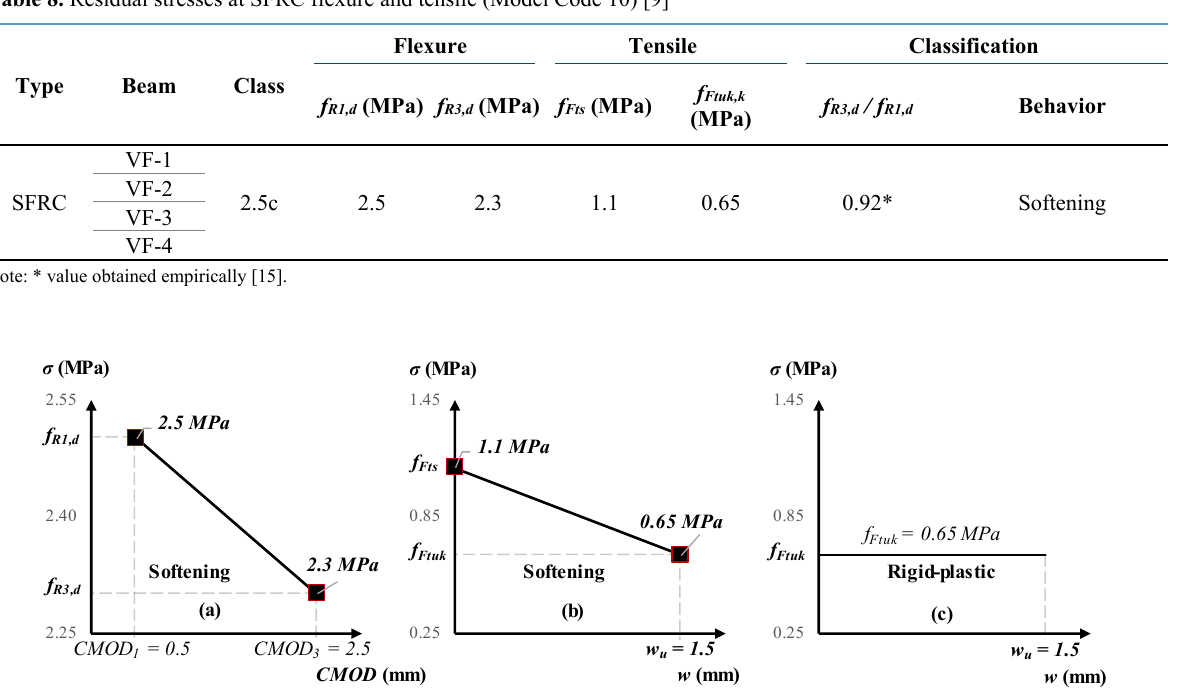
Figure 14. (a) Flexural response, (b) Softening Tensile response and (c) Rigid-plastic Tensile